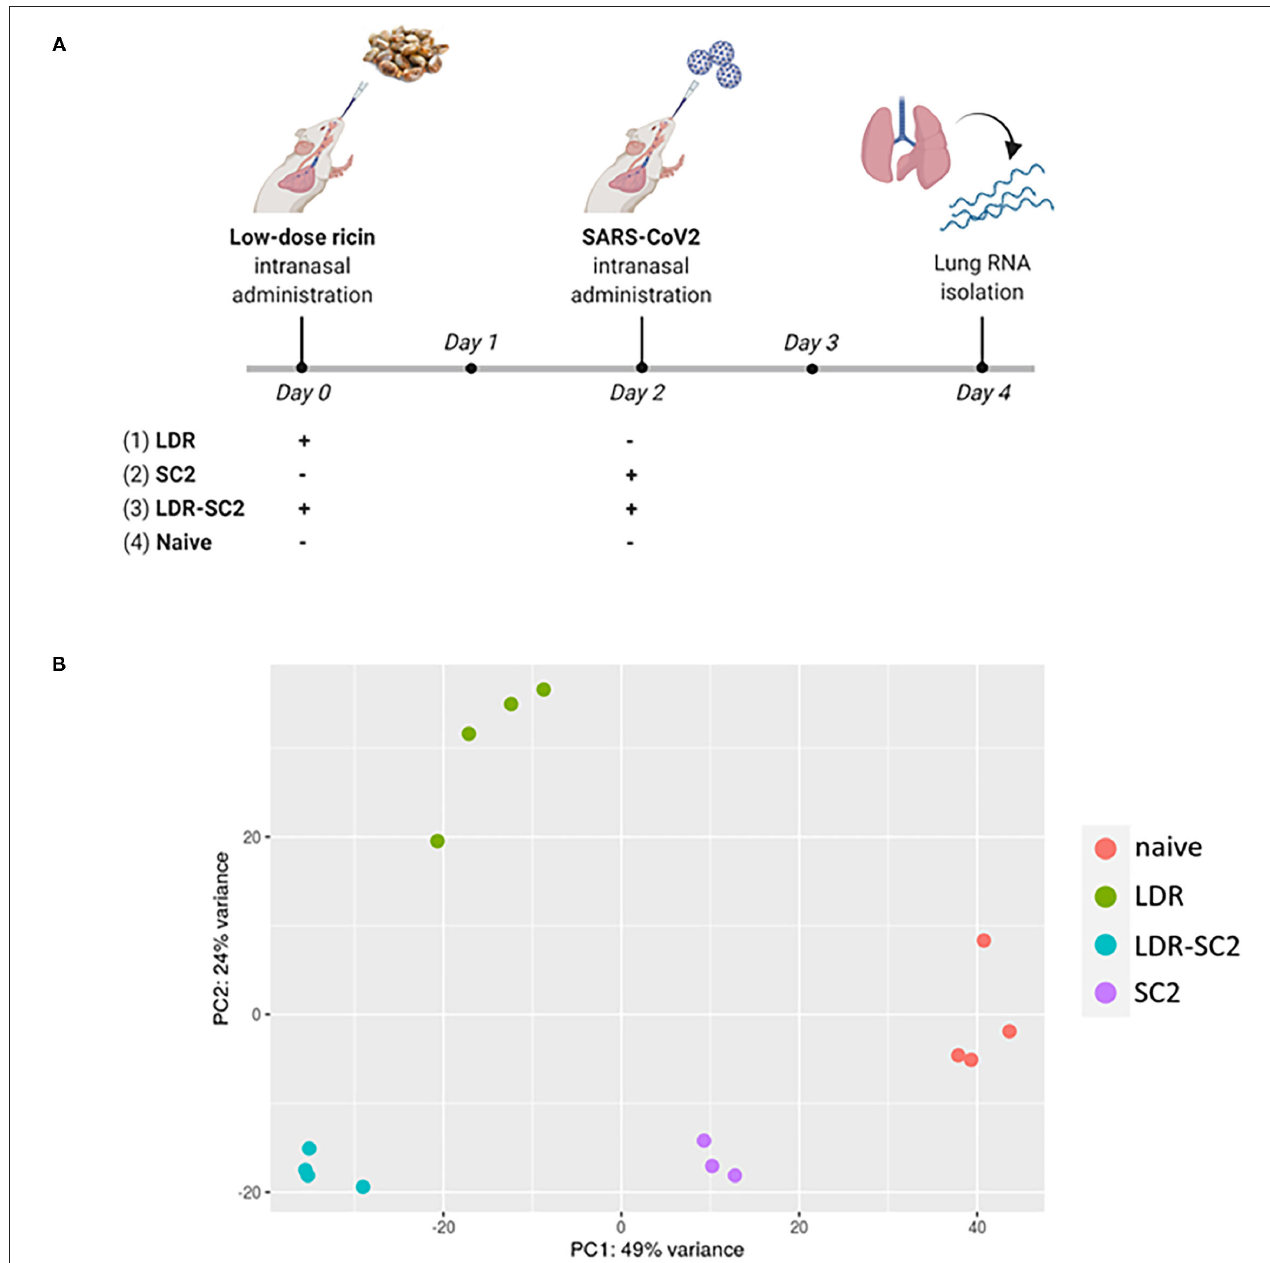
FIGURE 1 | (A) Time-table for treatment and lung harvest for RNA-seq analysis of the various mice groups. The scheme was created with BioRender.com. (B) PCA scatter plot of gene expression in lungs of mice. PCA analysis shows clustering of RNA-seq samples by treatment.